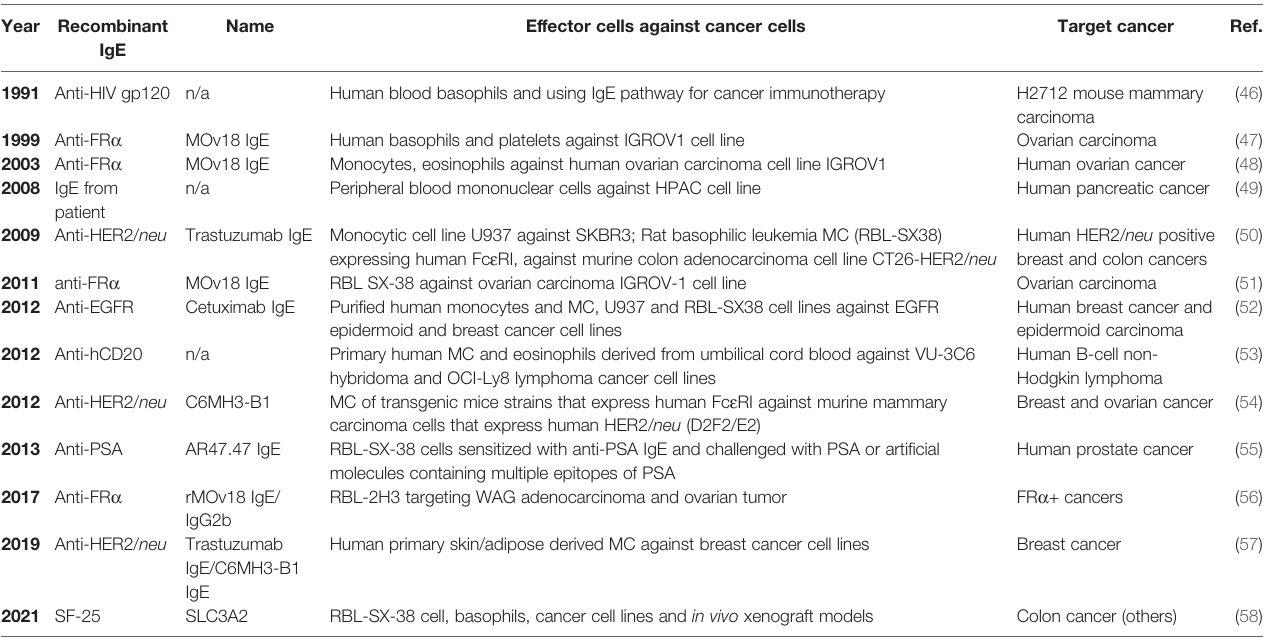
TABLE 2 | In-vitro studies of IgE dependent cancer